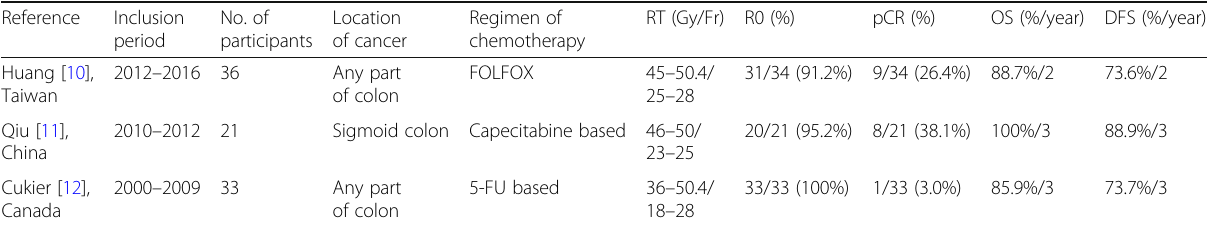
Table 1 Previous studies of pathological complete response of locally advanced colon cancer after neoadjuvant